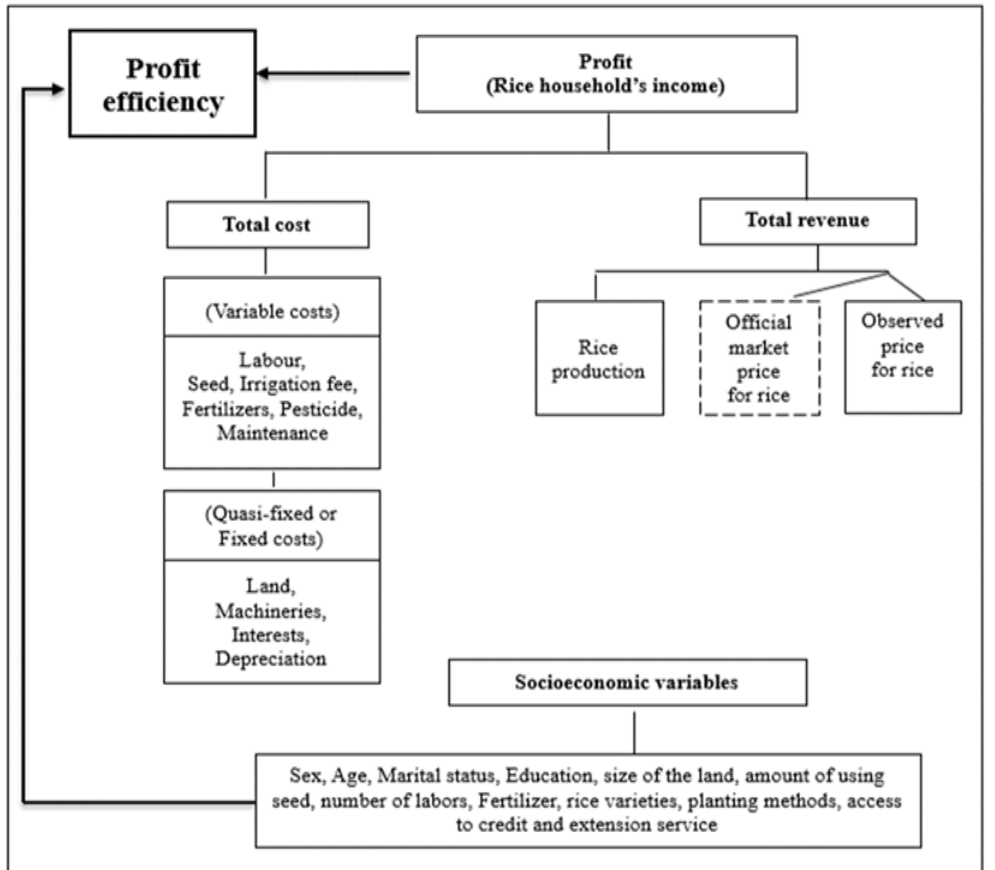
Figure 2. Profit System of Wet-Season Lowland Rice.